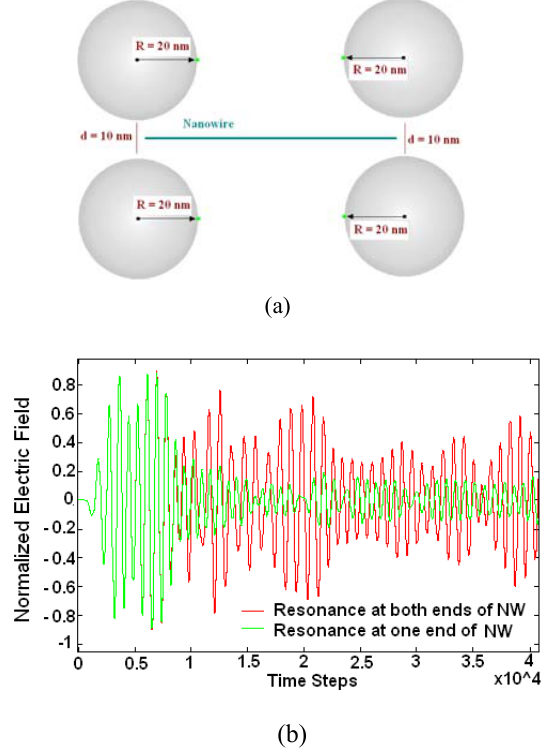
Fig. 3: (a) Structure for example 2, (b) Electric field at NW with l ocalized fi eld at o ne en d and l ocalized f ield a t b oth ends of the nanowire.